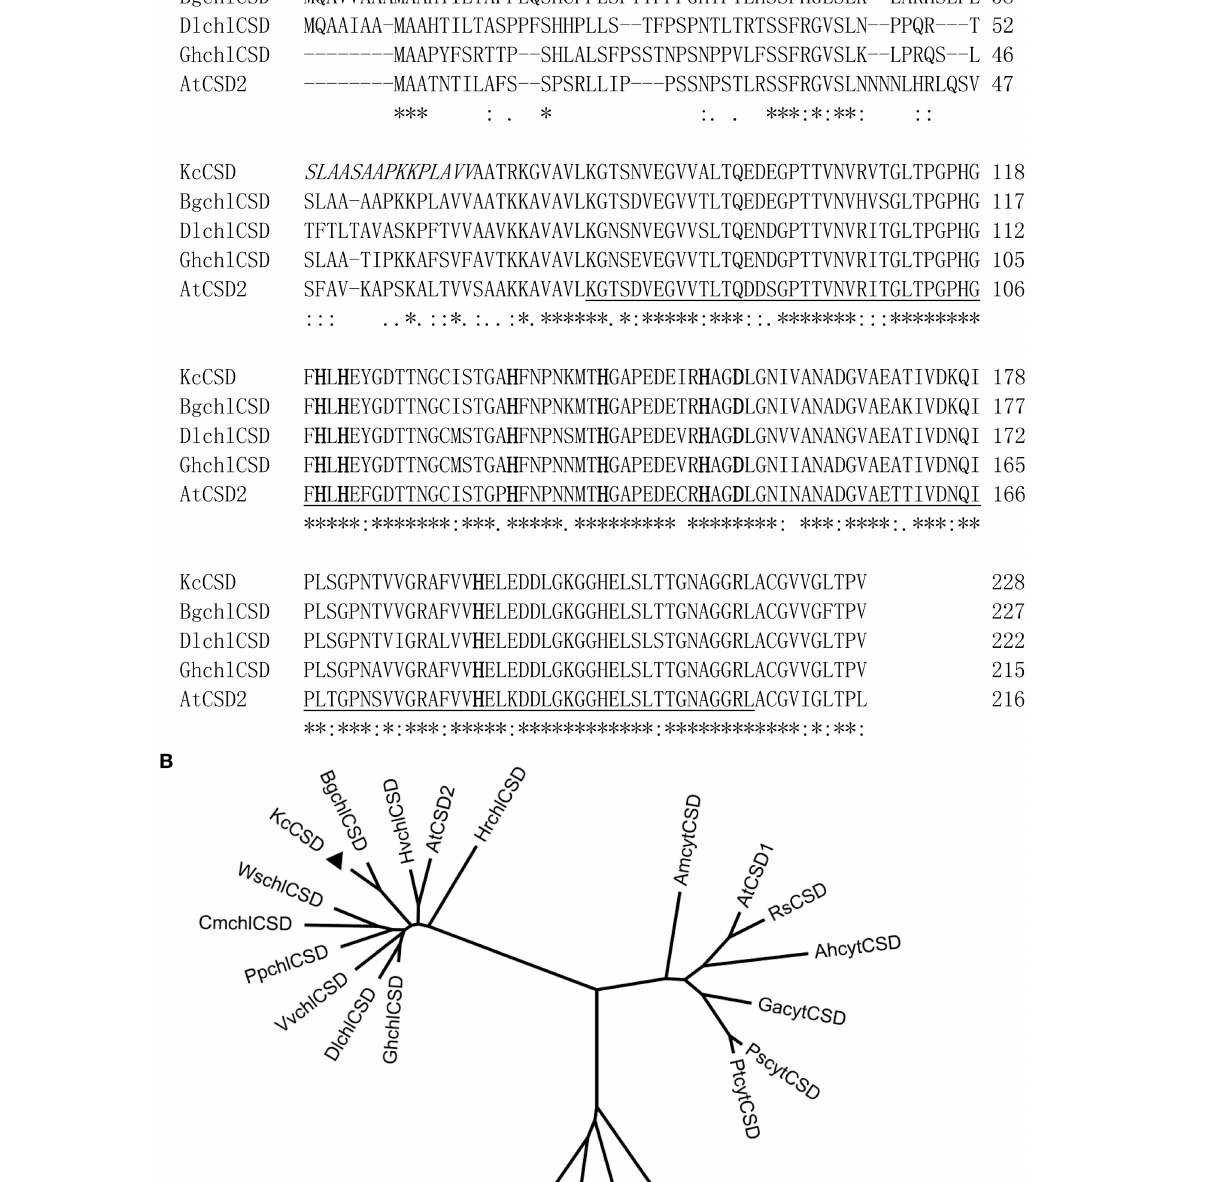
in various species. The alignment used for this analysis is available from the database (Supplementary Table S1). Different species acronyms are: Ah , Amaranthus hypochondriacus ; Am , Avicennia marina ; At , Arabidopsis thaliana ; Bg , Bruguiera gymnorrhiza ; Br , Brassica rapa subsp. Pekinensis